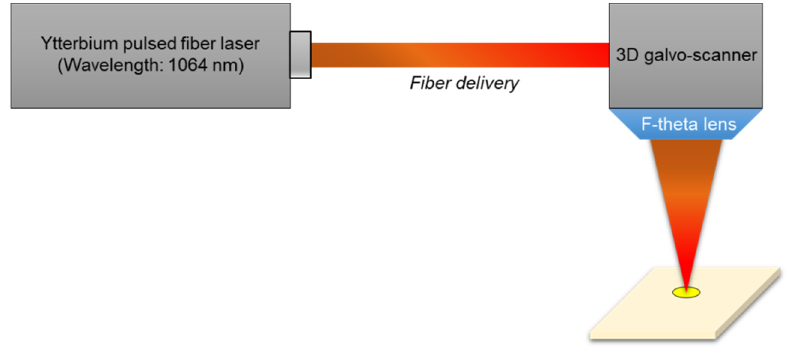
Figure 2. Schematic illustration of laser spot cutting system.